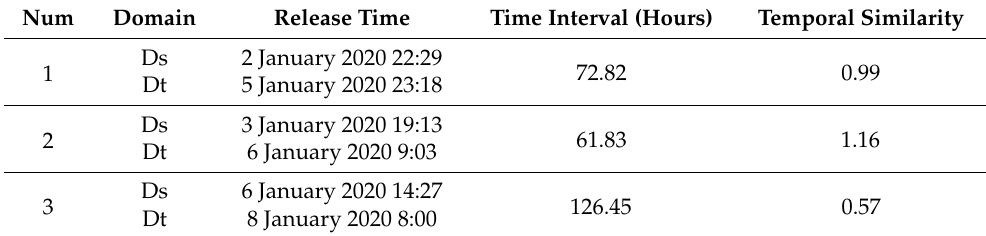
Table 2. Temporal similarity of T1 time slice data in the D s and D t